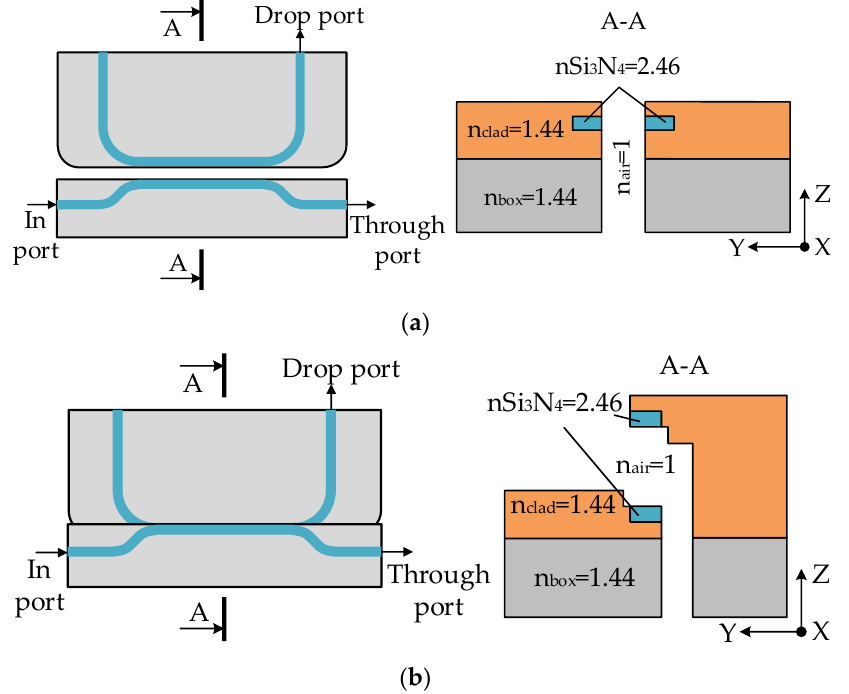
Figure 7. External view of the OMT. ( a ) Same-plane waveguides; ( b ) Different-plane waveguides. The optical transmission coefficient ( T drop ) is the relation of the transmitted optical power ( P drop ) at the output of the drop port to the input power ( P input ), and is determined as follows [44]: The dependencies of the optical transmission coefficient T drop for the drop port on the air gap G and coupling length L co for different fabrication technologies are presented in Figure 8. The calculations were made in the COMSOL Optics software package using the Finite-Difference Eigenmode (FDE) solver. The coupling length under study was limited to 100 µm due to the fabrication technology and to reduce the risk of moving and fixed parts of the MEMS structure touching each other; the air gaps under investigation were limited to 600 nm to reduce the crystal area and coupling length of the photonic integrated circuit (PIC).